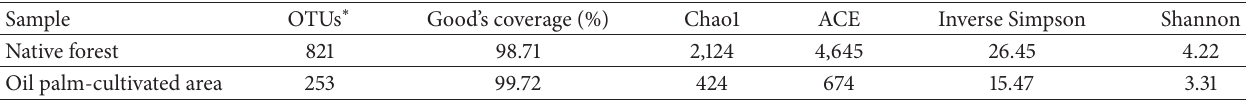
Table 1: Number of operational taxonomic units (OTUs), Good’s coverage estimator, OTU richness indices (Chao1, ACE), and Inverse Simpson and Shannon diversity indices for archaeal communities in native forest soil and soil under oil palm cultivation.